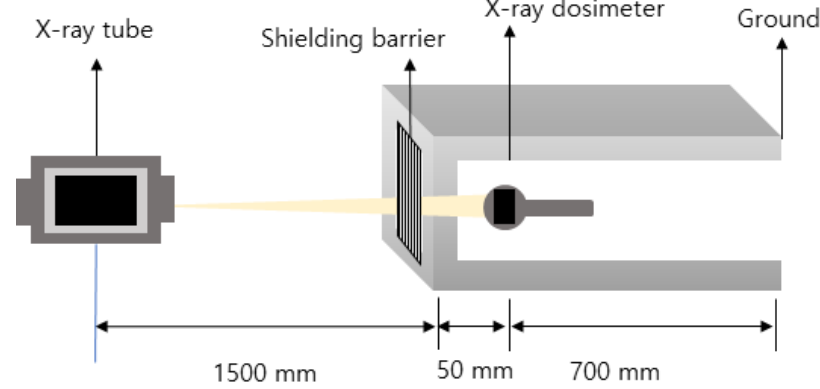
Figure 2. Shielding performance evaluation diagram of X-ray barriers.